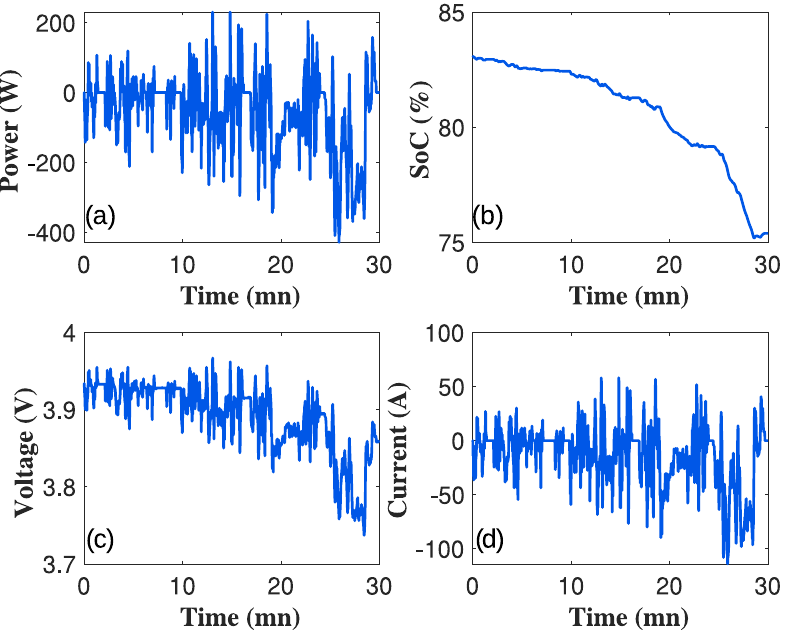
Figure 10. ( a ) Power, ( b ) state of charge, ( c ) voltage and ( d ) current evolution during a Worldwide Harmonized Light Vehicles Test Cycle